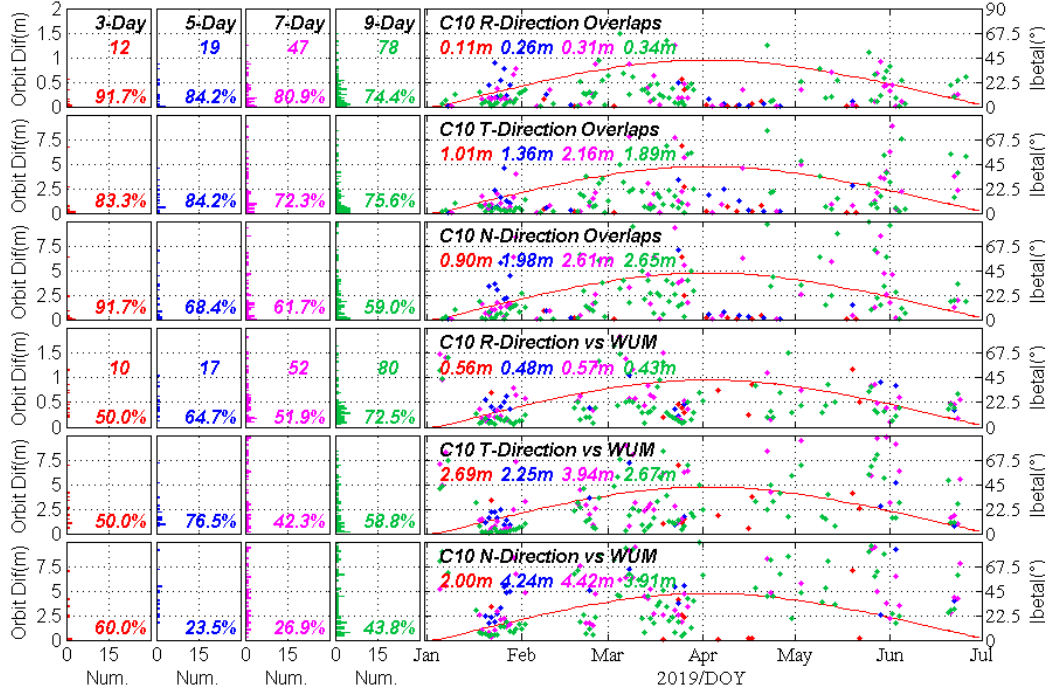
Figure 8. The results of SLR-only orbit determination for C10.